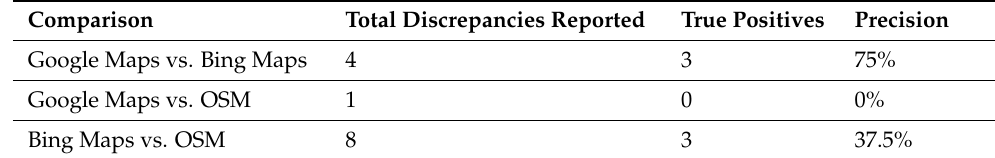
Table 4. Type 2 Discrepancy precision metrics in Spain.